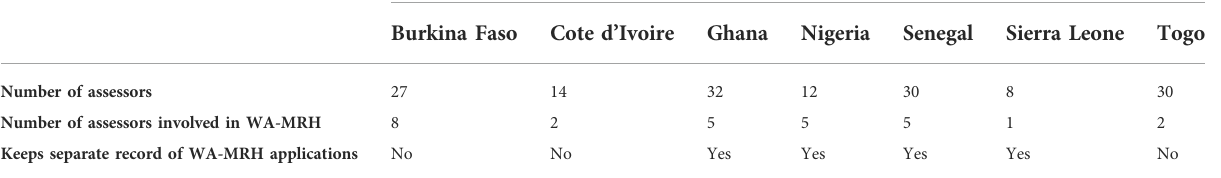
TABLE 1 Technical and administrative resources of